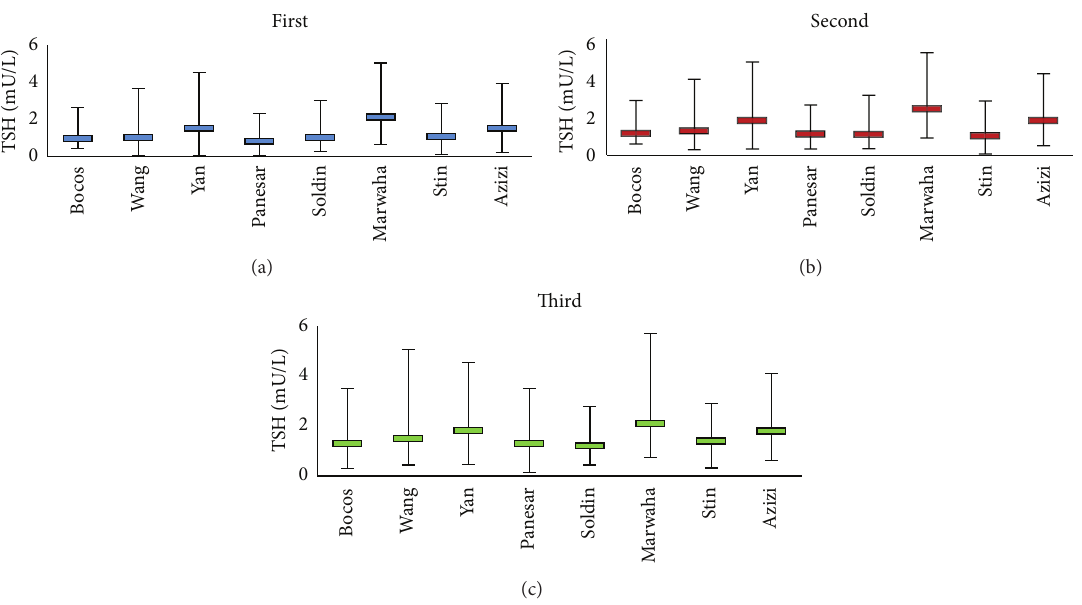
Figure 3: Comparison of trimester specific TSH reference ranges reported